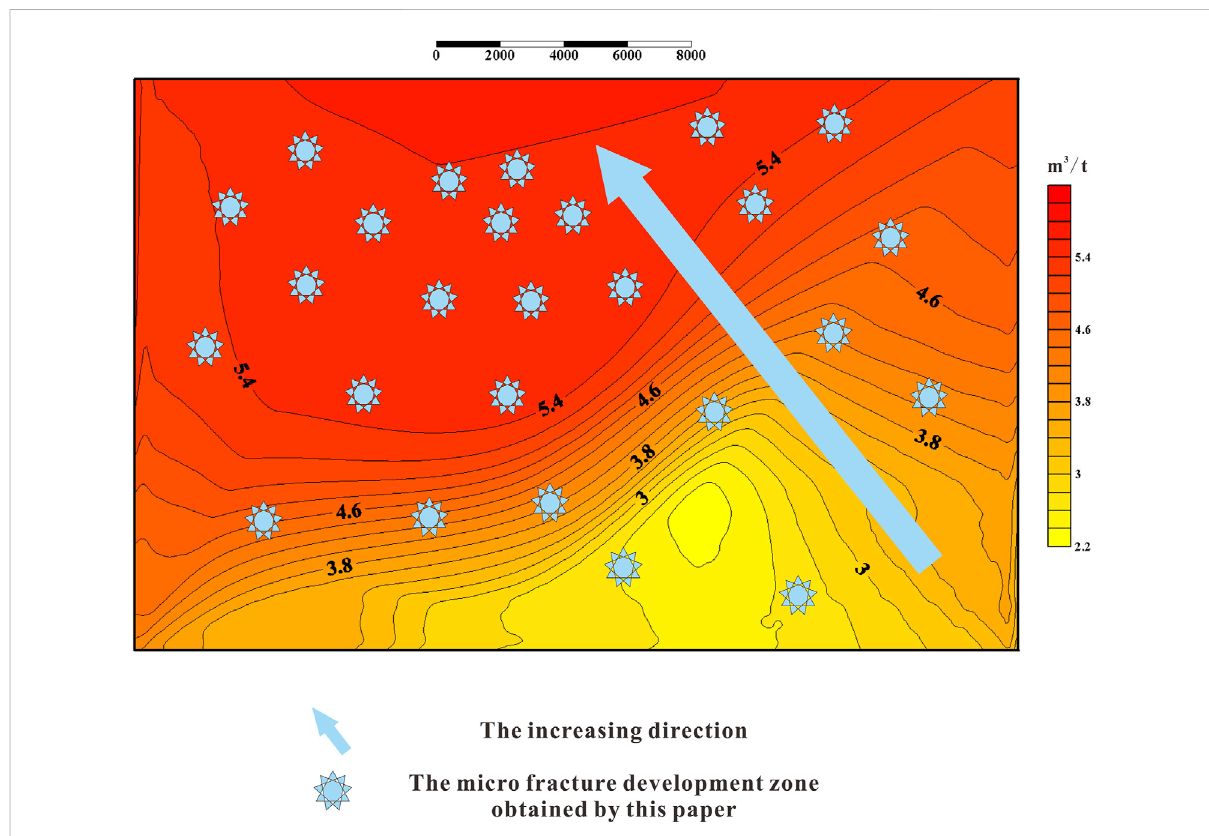
FIGURE 9 Microfracture development area and its growth trend. And gas content contour